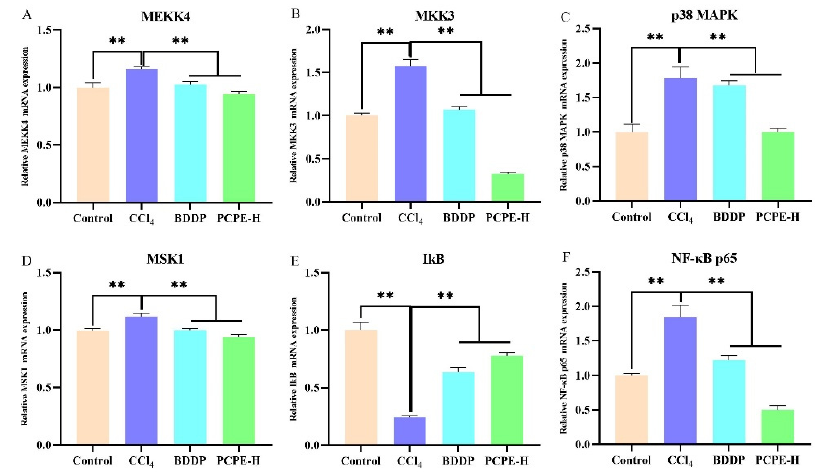
Figure 6. PCPE effects on MAPK/NF- κ B signaling pathways. ( A ) MEKK4, ( B ) MKK3, ( C ) p38MAPK, ( D ) MSK1, ( E ) IkB, ( F ) NF- κ B p65. Data represented as Means ± SD. ** indicates p < 0.01.